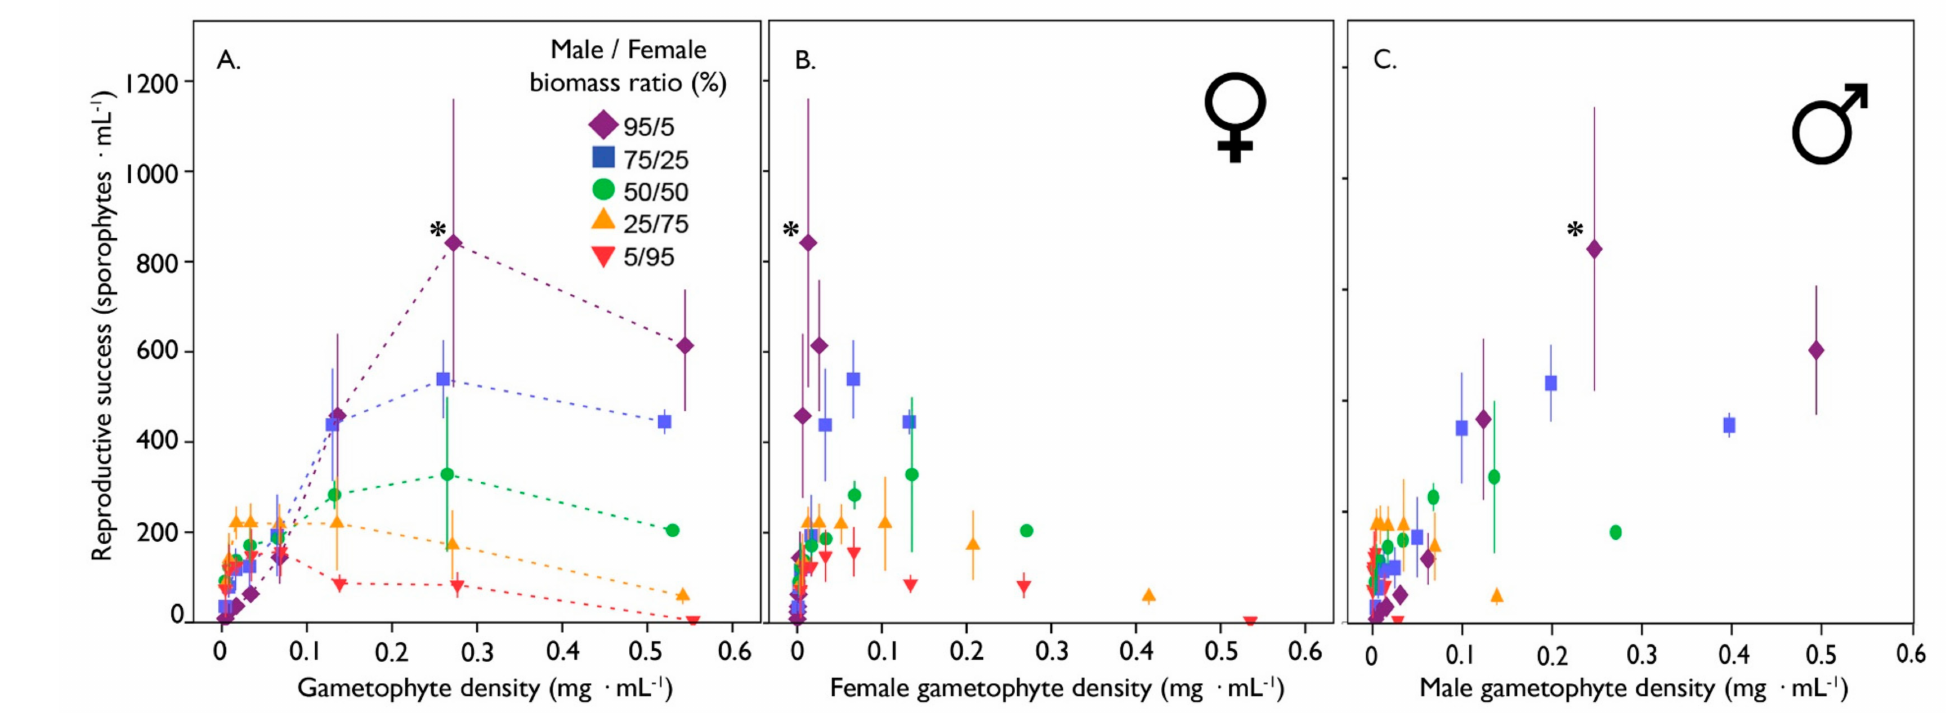
Figure 2. ( A – C ) The initial gametophyte density of both sexes (x-axis a ; mg · mL − 1 ), the female gametophyte density (x-axis b ; mg · mL − 1 ) and the male gametophyte density (x-axis c ; mg · mL − 1 ) versus the reproductive success (y-axis; sporophytes · mL − 1 ) of S. latissima gametophytes. The male:female ratios are described in the figure and symbols of these gradients are included in all three figures to allow for comparisons. The (*) is added to visually elaborate how the female gametophyte density ( B ) and male gametophyte density ( C ) are added up to form gametophyte density ( A ). Linear interpolation lines are added in A for added readability. Values are expressed as mean ± SD, n =